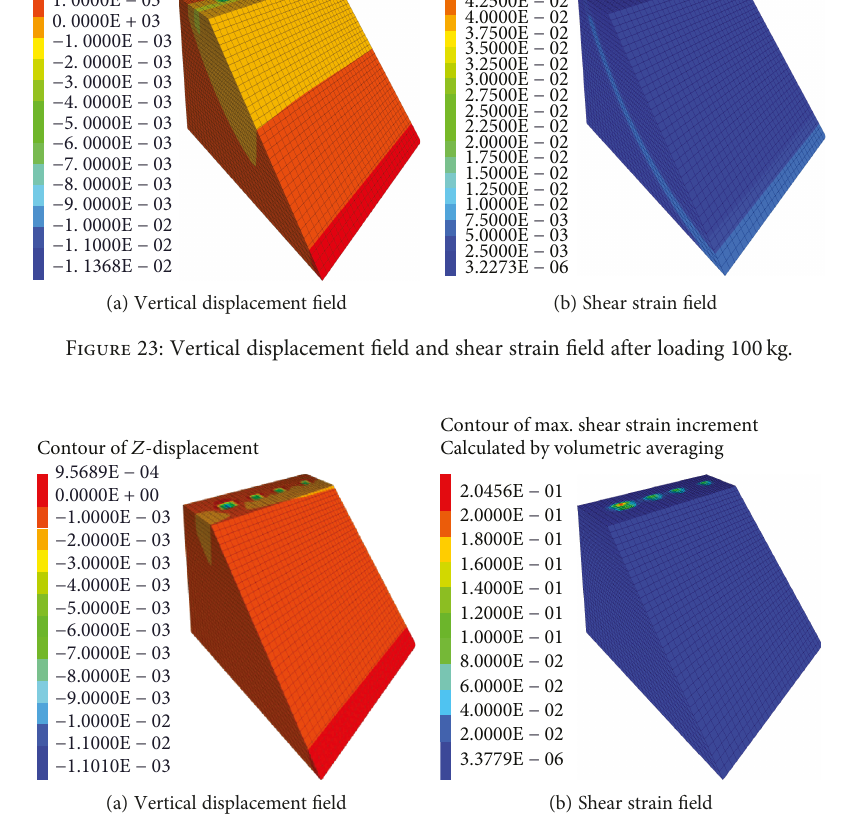
Figure 24: Vertical displacement fi eld and shear strain fi eld after loading of